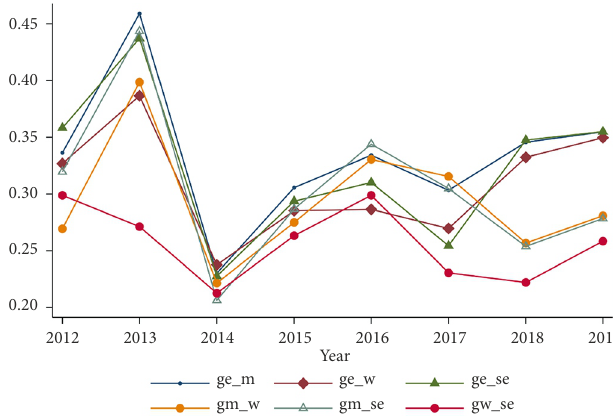
Figure 5. The Gini coefficient trends of the urban resilience in regions from 2012 to